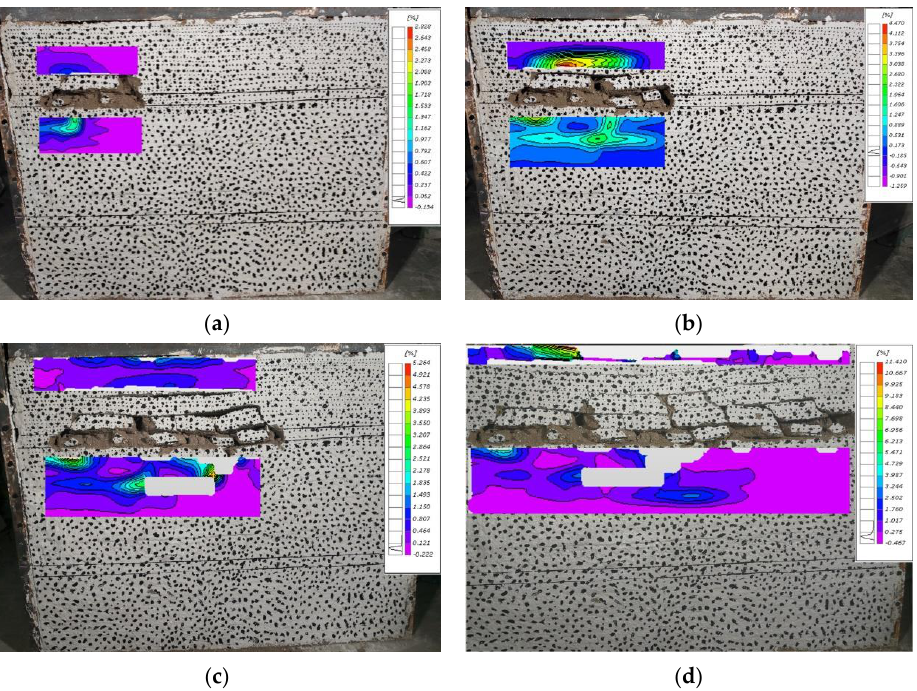
Figure 17. Strain diagram of working face advancing at different distances: ( a ) strain diagram of simulated working face advancing 30 m; ( b ) strain diagram of simulated working face advancing 50 m; ( c ) strain diagram of simulated working face advancing 60 m; and ( d ) strain diagram of simulated working face advancing 80 m.